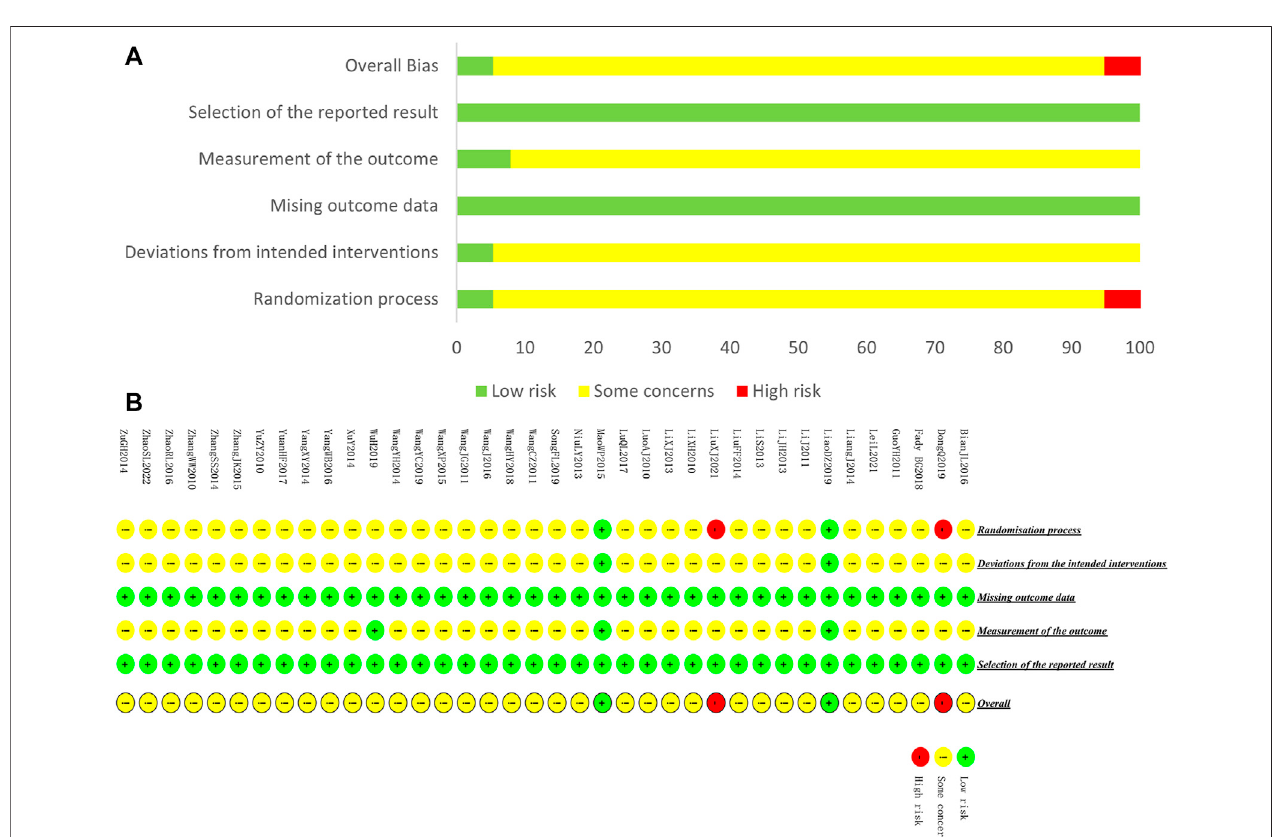
FIGURE 4 | Risk of bias of included studies. (A) Risk of bias graph (B) Risk of bias summary.